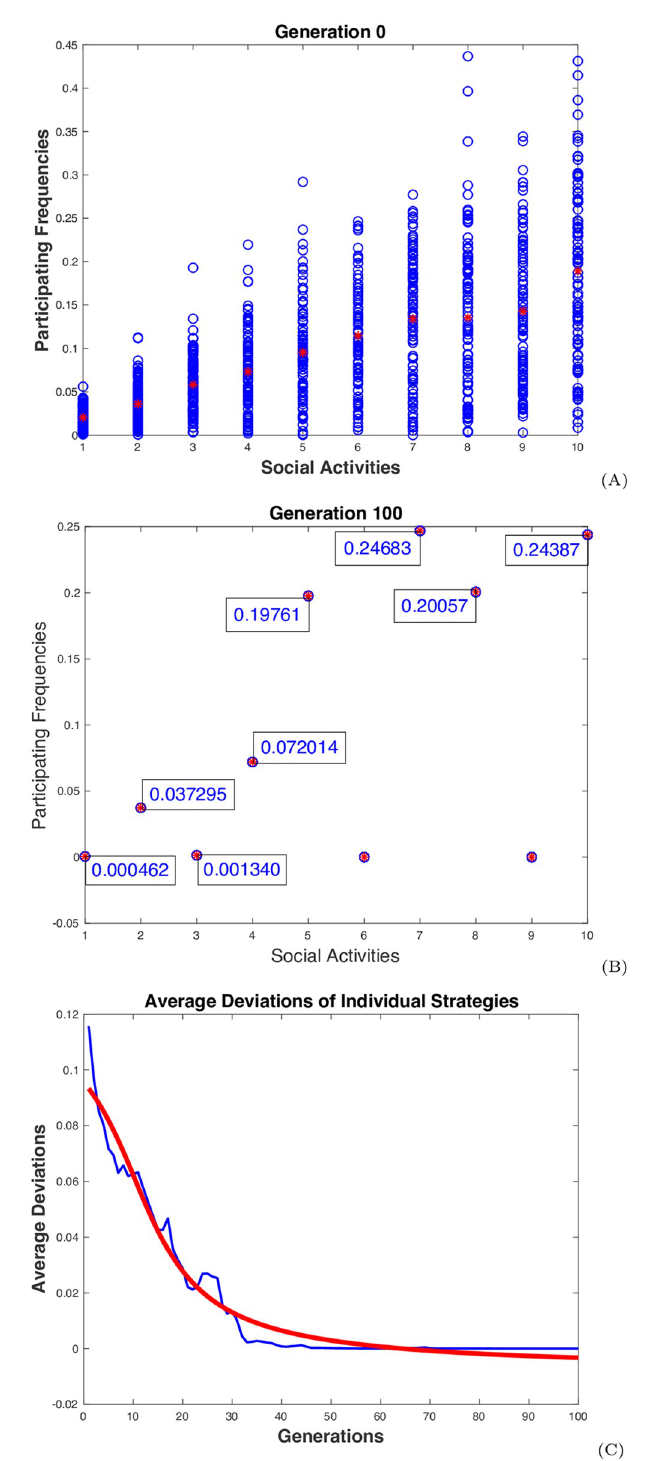
Fig 4. Dynamic behaviors of the distancing population. The simulation results from a typical test run for a population of 100 individuals with 10 dependent activities are displayed: The graphs (A) and (B) show the initial and final distributions of the individual frequencies over the 10 activities. The activities are listed on the x -axis. The frequencies are displayed in blue circles, one for one individual on one activity. The red stars represent the average frequencies of the population. The blue curve in graph (C) shows the changes of the averaged RMSD of the individual frequencies over generations. The red curve is a smoother regression showing the general trend of the changes.